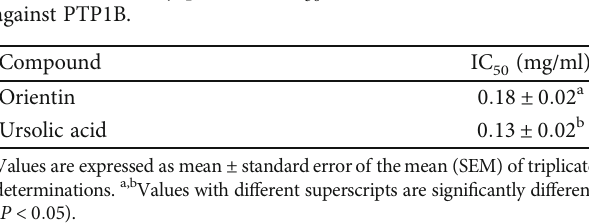
) of orientin and ursolic acid 50